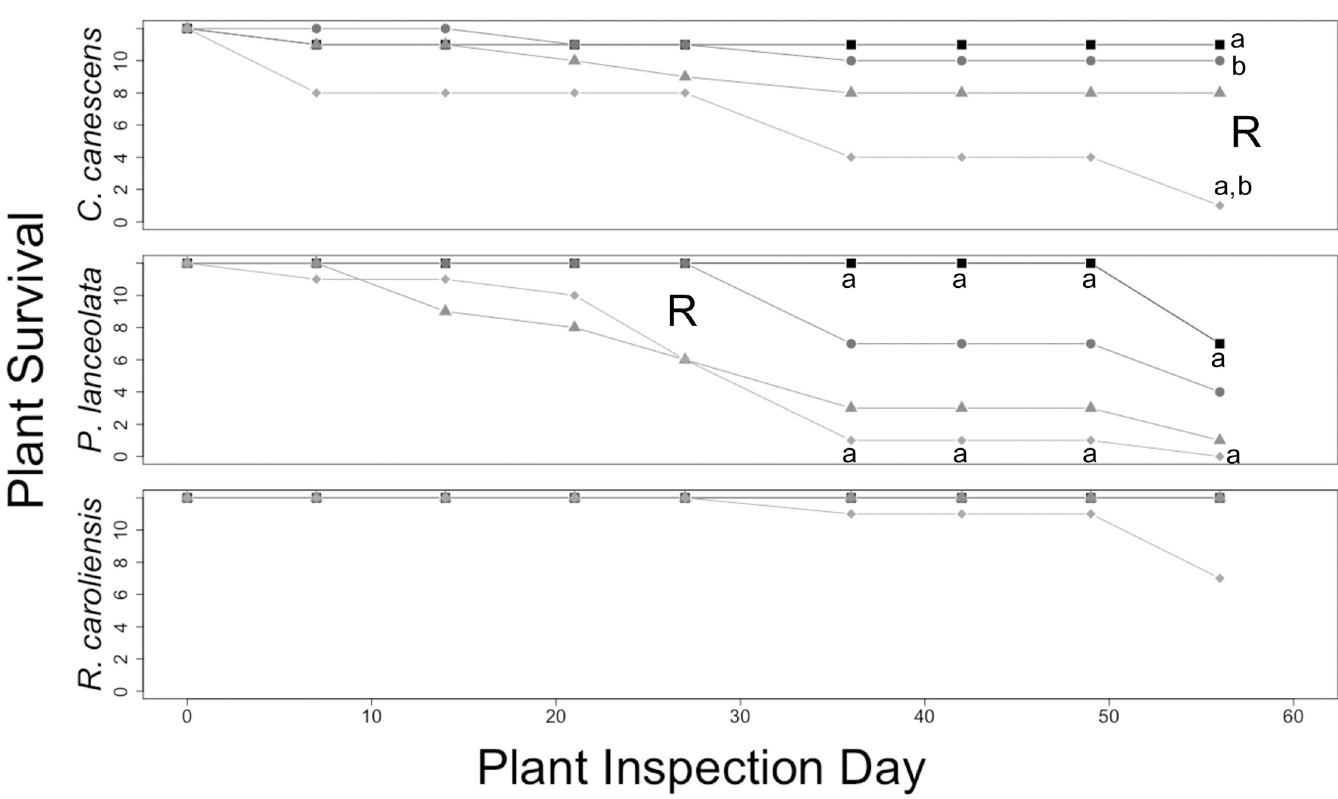
Fig 9. Plant survival in outdoor plot trial. Numbers of surviving C . canescens , P . lanceolata , and R . caroliniensis under four treatments over 56 days. Treatments included reduced water-resourcing (1X vs. 0.5X) and soil contamination with RDX (0 vs 100 ppm). R = day by which significant differences in survival had emerged (adjusted α = 0.05); a–b = day by which significant pairwise difference between treatment groups (designated by same letter) emerged (adjusted α = 0.017).